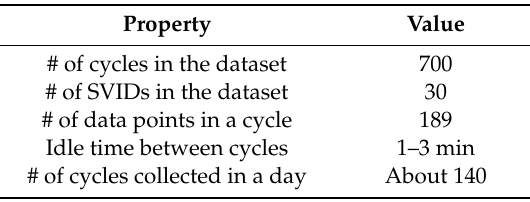
Table 6. Dataset properties in Section 6.2.